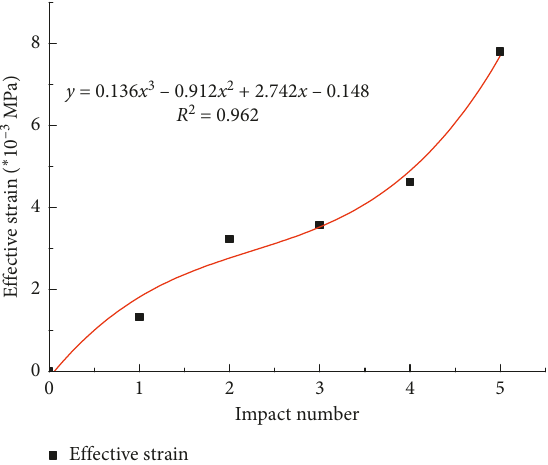
Figure 11: Relationship between effective strain and impact Figure 12, the pendulum is a cylinder and is connected with the bearing via a pendulum rod. When calculating the impact energy of the pendulum on the coal sample, the equivalent mass of the pendulum and the pendulum rod must be considered (the pendulum rod has greater influence on the equivalent mass, while other components of the equipment have less influence) [30]. The actual measure- ment shows that the effective length of the pendulum rod L 0.73 m; the mass of the pendulum rod m 2 0.457 kg; the (cid:31) (cid:31) pendulum mass m 1 1.303 kg; and the pendulum diameter (cid:31) d 0.06 m. (cid:31)